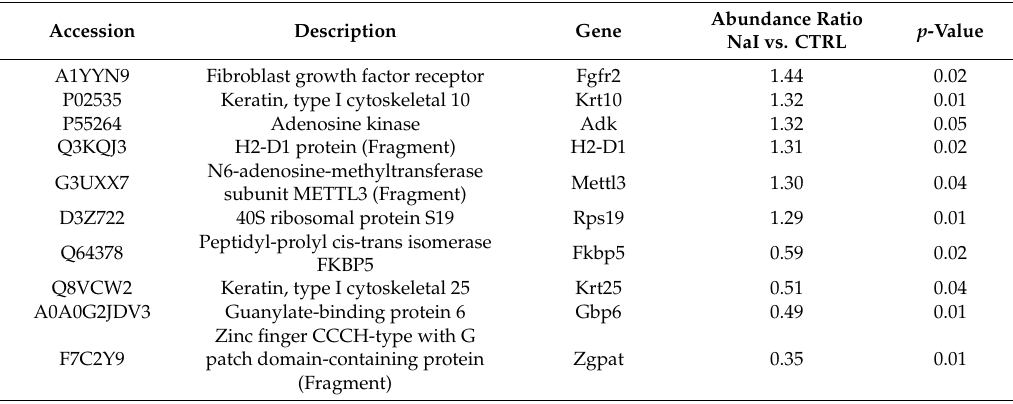
Table 1. Top 10 list of the most induced and most inhibited proteins in NaI vs. CTRL.